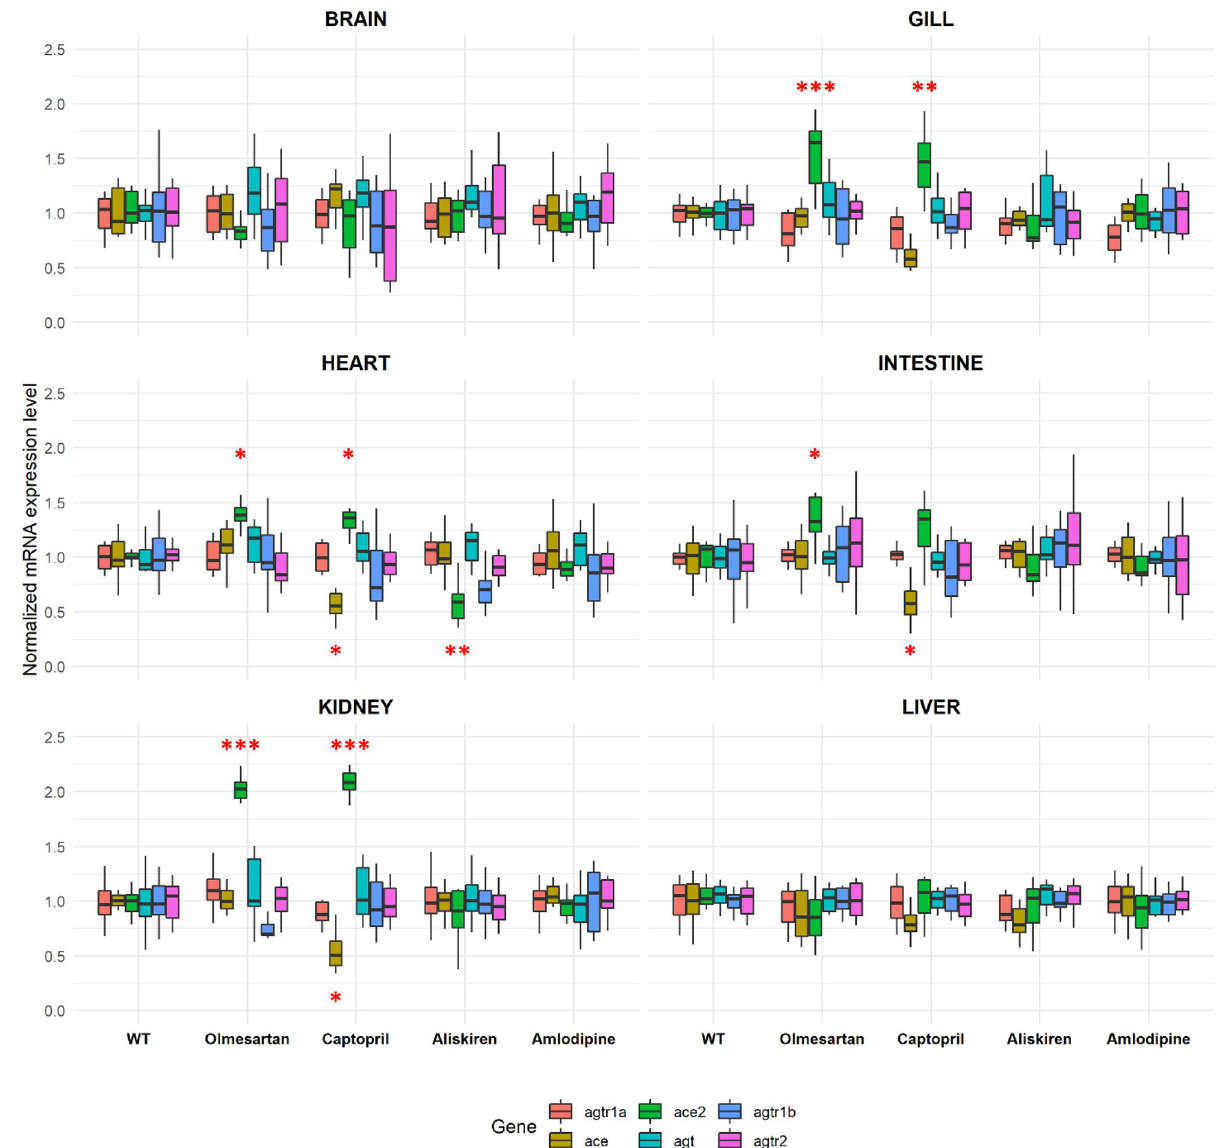
Figure 4. Tissue-specific up-regulation of ace2 expression by RAAS inhibitors. The ace2 expression was significantly increased in captopril and olmesartan treated groups compared to the DMSO control in the gill, heart, and kidney (n = 6 per gene-organ-drug combination, * p < 0.05, ** p < 0.01, *** p < 0.001 unpaired t test). Olmesartan also increased ace2 expression in the intestine (n = 6, p < 0.05, unpaired t test). Aliskiren treatment significantly decreased the ace2 expression in the heart; captopril treatment decreased ace expression in the heart, intestine, and the kidney (n = 6, p < 0.05, unpaired t test). Olm: olmesartan, Cap: captopril, Ali: aliskiren, Amlo: